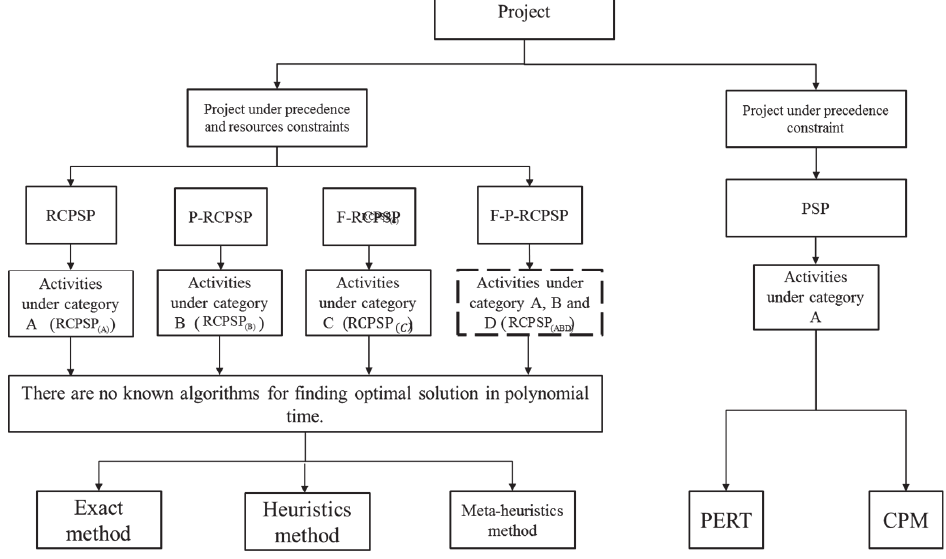
Fig. 8. Our vision for the new activity assumptions in the RCPSP and